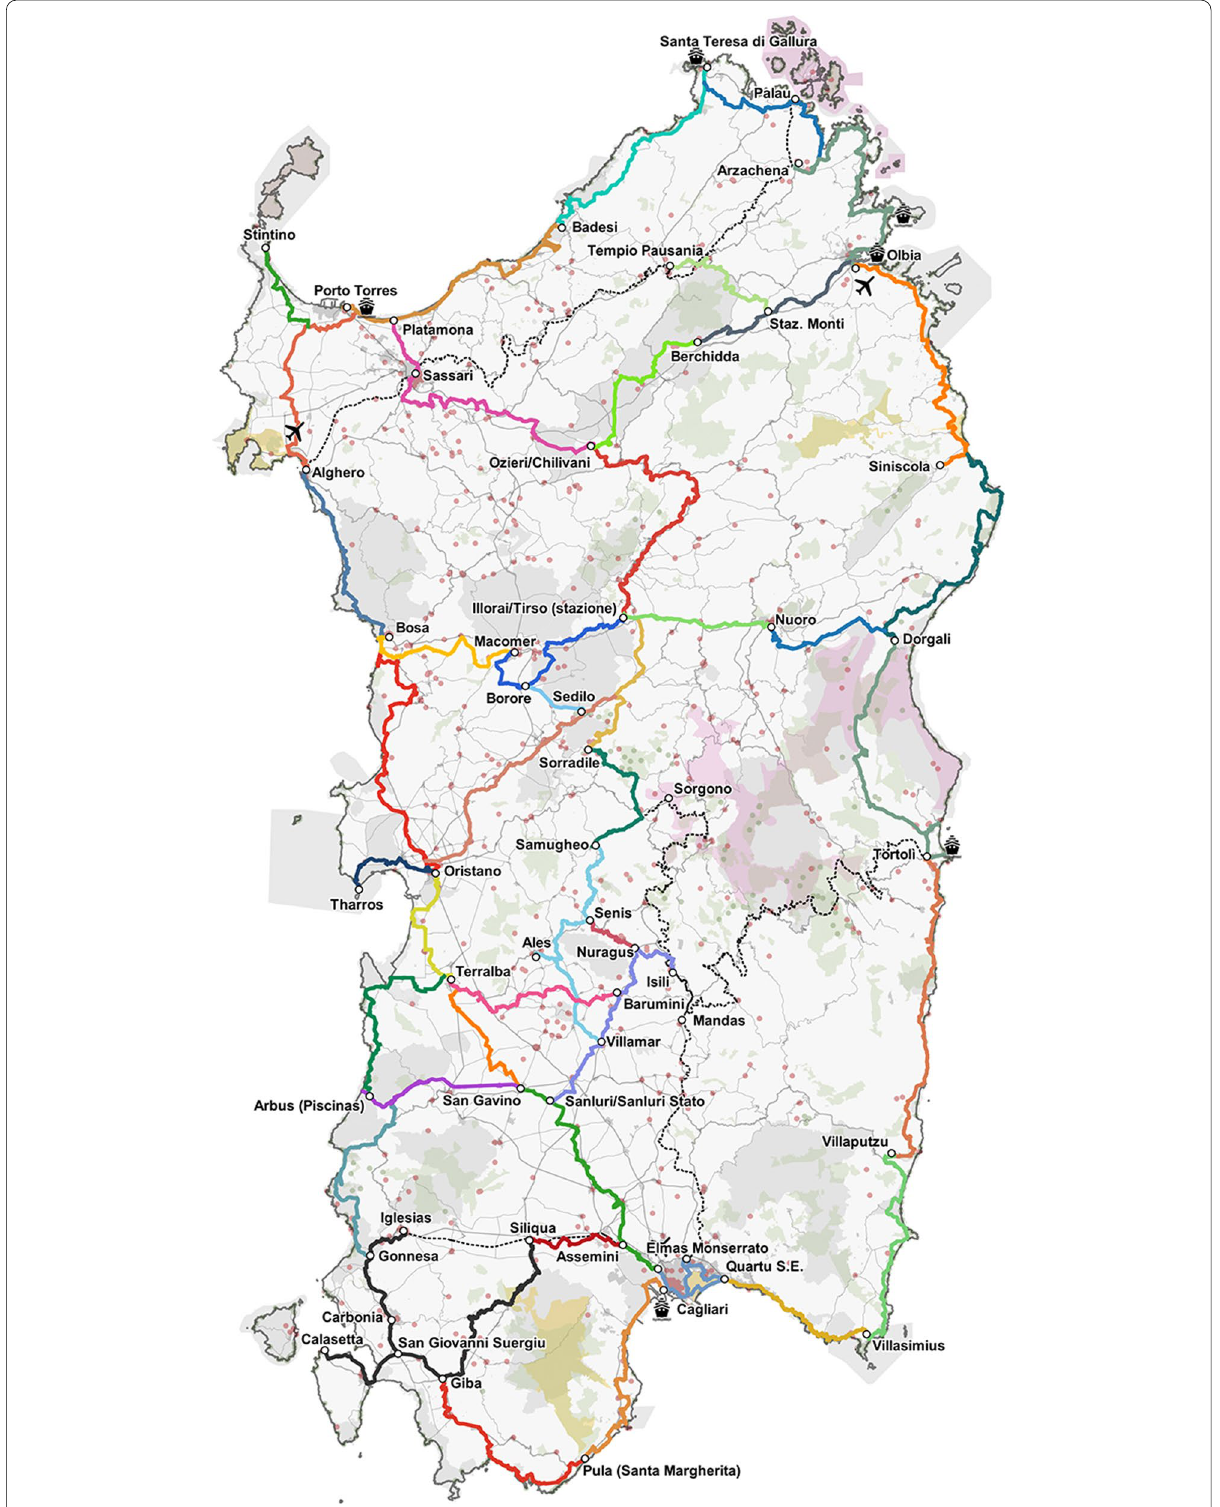
Fig. 8 The regional cycle network of